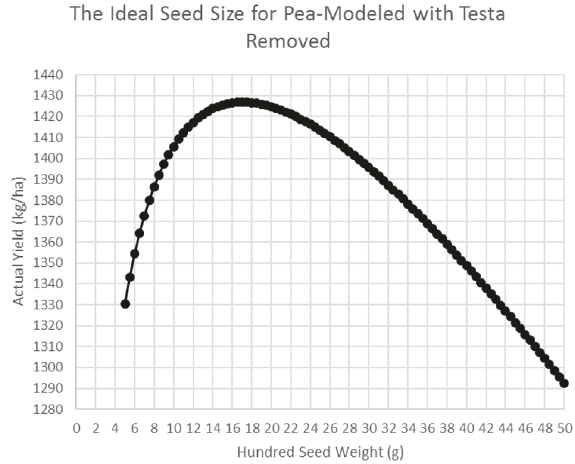
Figure 3: The ideal seed size for pea-modeled with seed testa removed. The ideal seed size is at the vertex of the curve.